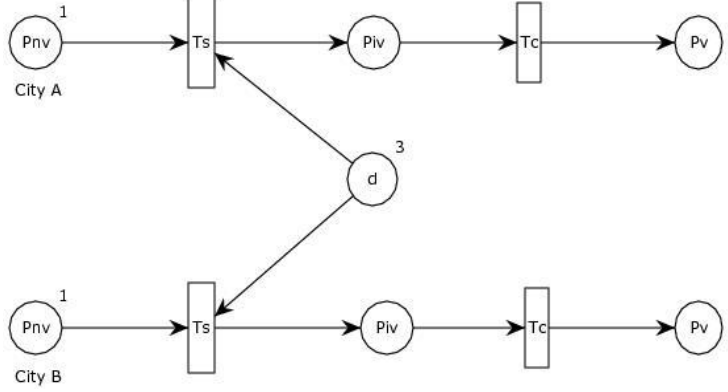
Figure 5. CPN model of a depo, two cities and three salesmen.